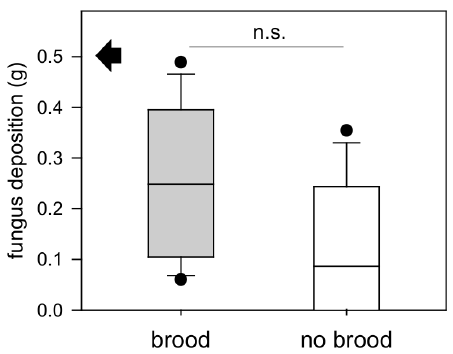
Figure 5. Experiment 6: Fungus deposition at nest sites (median ± 25–75% percentiles, min max values and outliers, n=15); black arrow indicates maximum possible fungus deposit; n.s.=not significant, p . 0.05 (Analysis of colony effects: Kruskal-Wallis test; brood site; H=1.94; p=0.38; n=5; non-brood site; H=2.2; p=0.33; n=5; n.s.; no colony effects found).